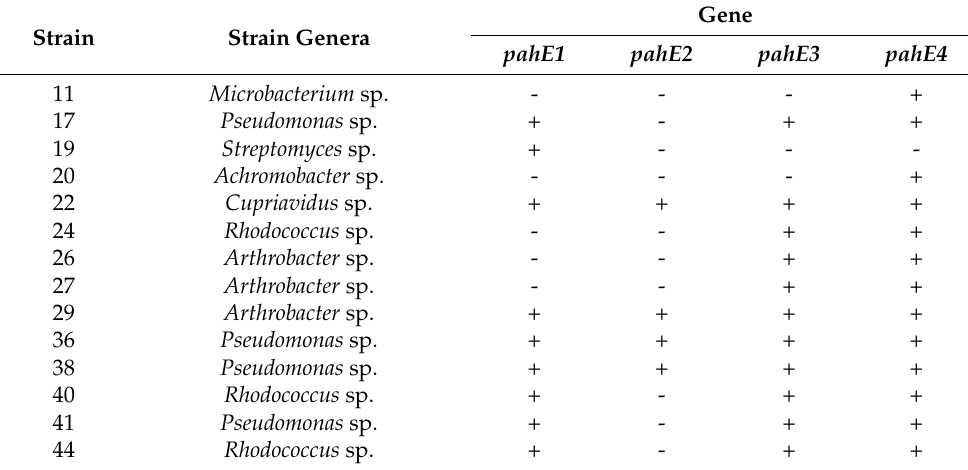
Table 1. Presence of genes related to PAHs decomposition in isolated strains: (+) presence of the gene, (-) absence of the gene. Strain Strain Genera